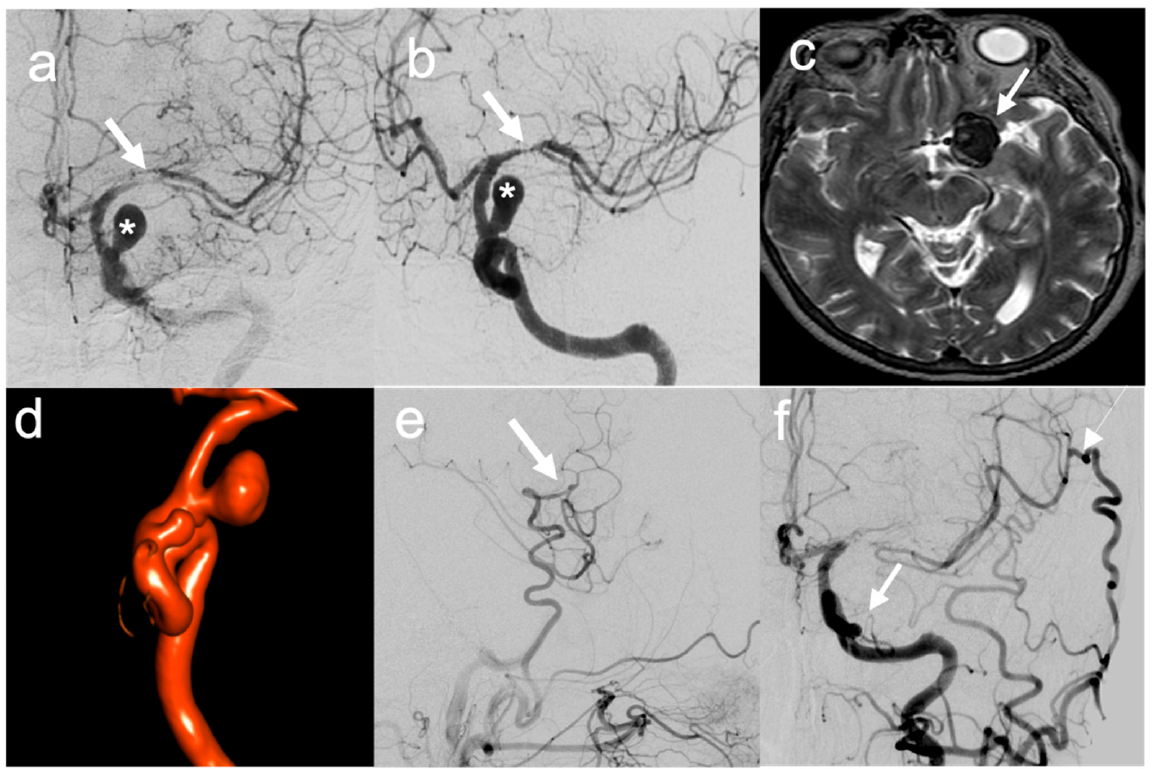
Figure 2. Illustrative case of “Complex” aneurysms with multidisciplinary treatment (bypass for flow preservation due to MCA compression/stenosis and endovascular coiling): ( a , b ) Preoperative DSA showing in frontal and lateral view MCA stenosis (arrow) and ICA aneurysm (*); ( c ) Preoperative T2 MRI showing aneurysm partial thrombosis; ( d ) 3D reconstruction of ICA aneurysm and identification of a second ICA aneurysm; ( e ) Postoperative DSA showing STA–MCA bypass patency in lateral view; ( f ) Follow-up DSA showing hypertrophic bypass patency (thin arrow) and aneurysm endovascular occlusion (large arrow).